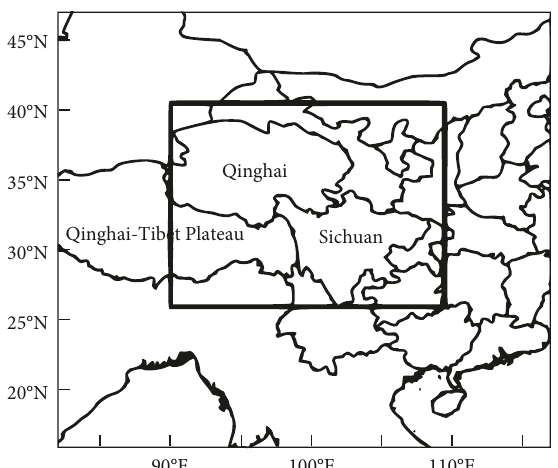
Figure 1: Case simulation domains; the outer frame is the D01 area and the inner frame is the D02 area.